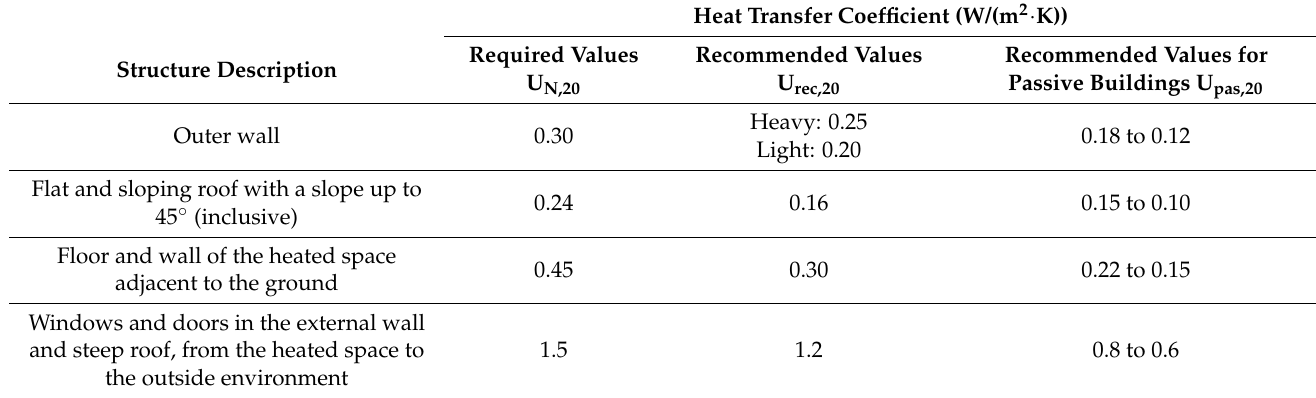
Table 2. Normative values of the heat transfer coefficient ( ˇCSN 73 0540-2: 2011 Thermal protection of buildings—Part 2: